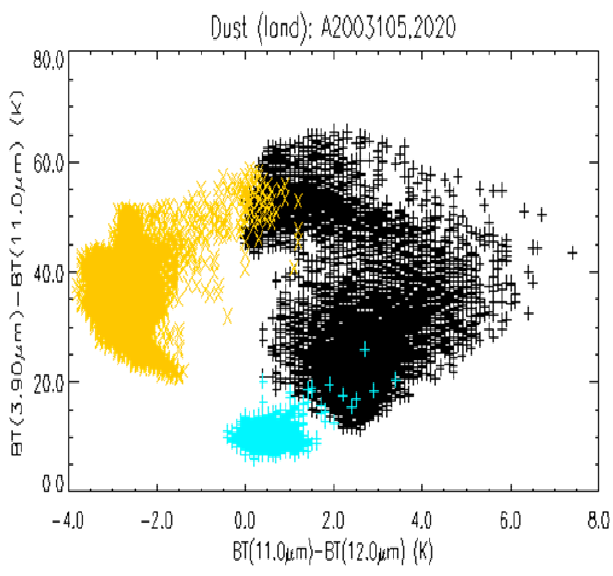
Figure 3. Scatter plot of the brightness temperature difference between MODIS 3.9 and 11.0 µm versus that between MODIS 11.0 and 12.0  m for dust (yellow x’s), clear-sky (light-blue crosses), and cloud (black